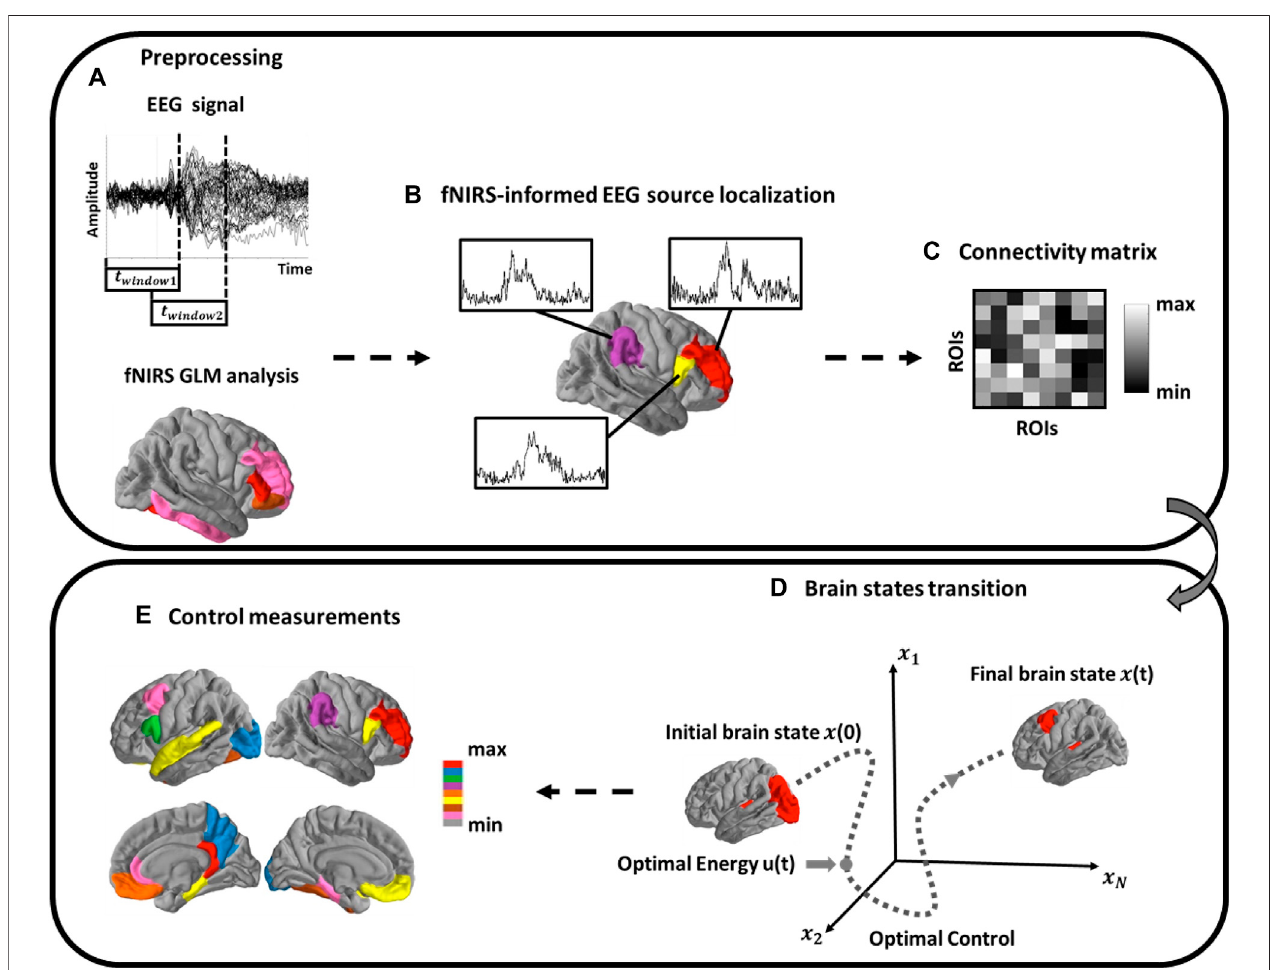
FIGURE 2 | Schematic of Methods. (A) EEG analysis using a sliding window scheme. FNIRS activation map is then extracted to form spatial priors; (B) Source localization analysis of cortical source activity; (C) Functional brain network construction; (D) Estimation of brain network dynamic process and the brain controllability analysis; (E) Calculate the modal controllability of each single brain